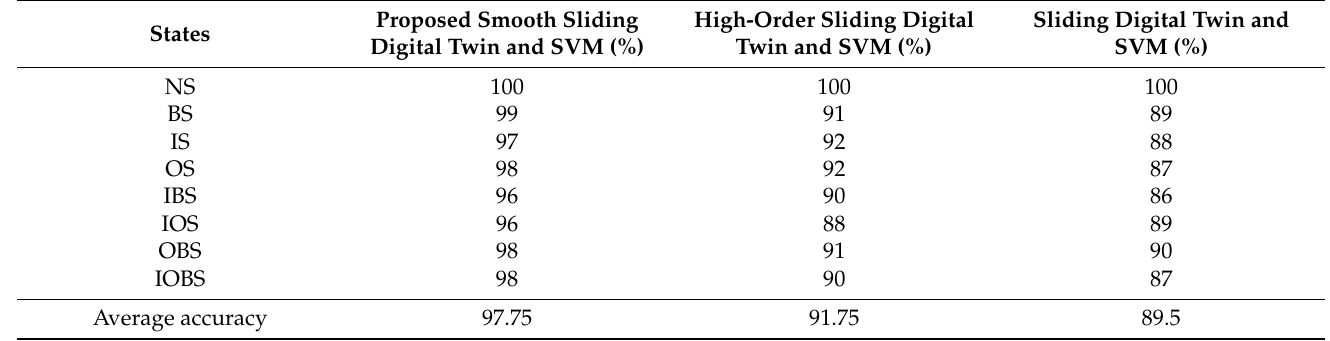
Table 4. Comparison between the combination of the proposed smooth sliding digital twin and SVM, high-order sliding digital twin and SVM, and sliding digital twin and SVM for anomaly diag- nosis.